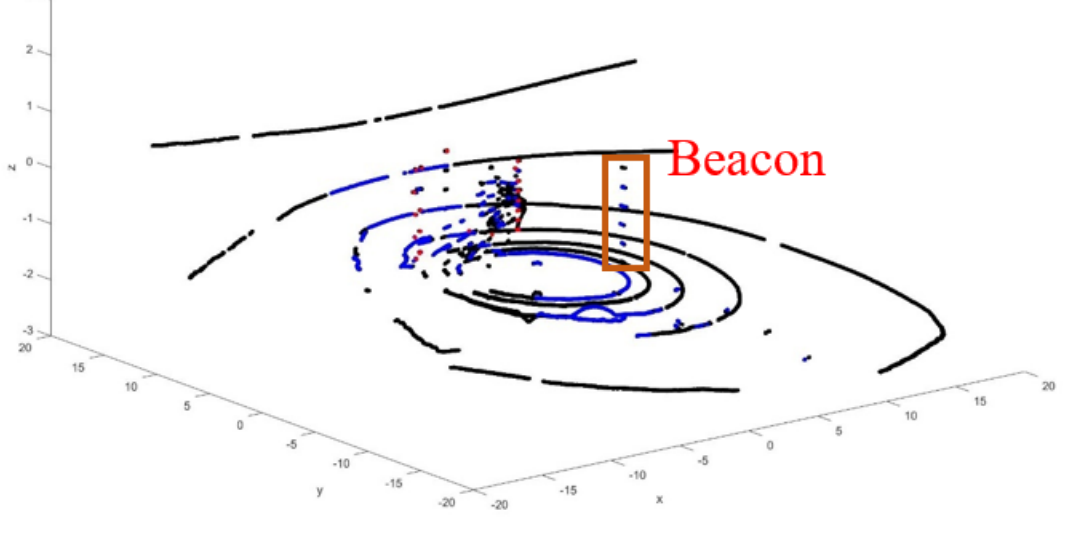
Figure 10. Detection via